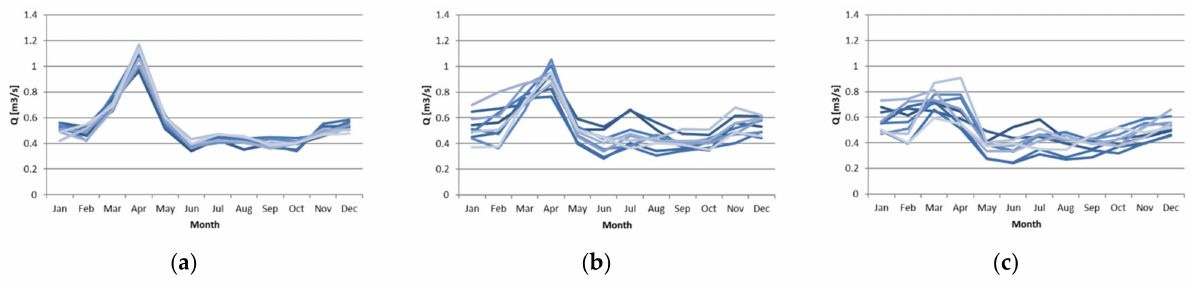
Figure 7. Shift in peak discharge from basin according to different climate scenarios: ( a ) 1980–2009, ( b ) 2010–2039, ( c ) 2040–2069.